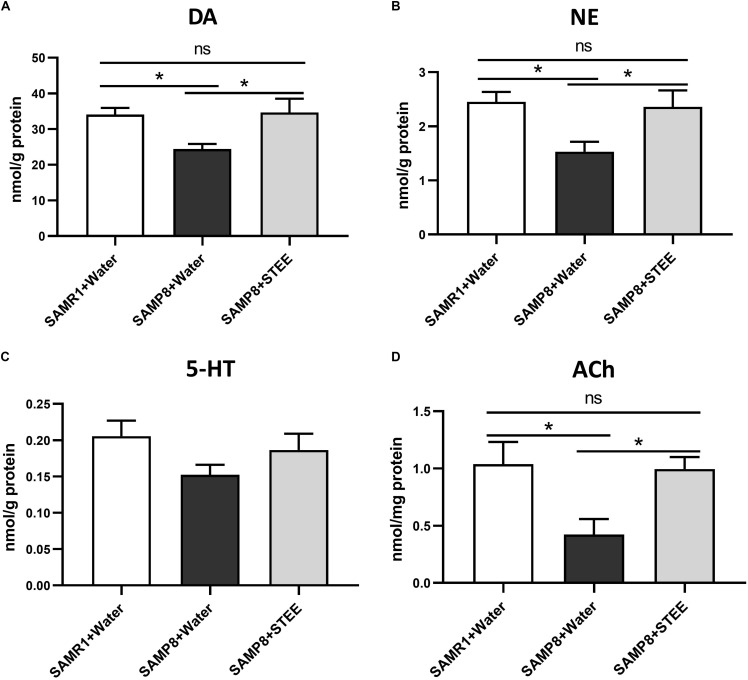
Levels of neurotransmitters in cerebral cortices. DA (A), NE (B), 5-HT (C), and ACh (D) levels in brain tissues were measured by ELISA. Values are presented as mean ± SEM (n = 5 animals per group). Comparisons were performed using one-way ANOVA with Fisher’s LSD test: *p < 0.05; ns, non-significant.